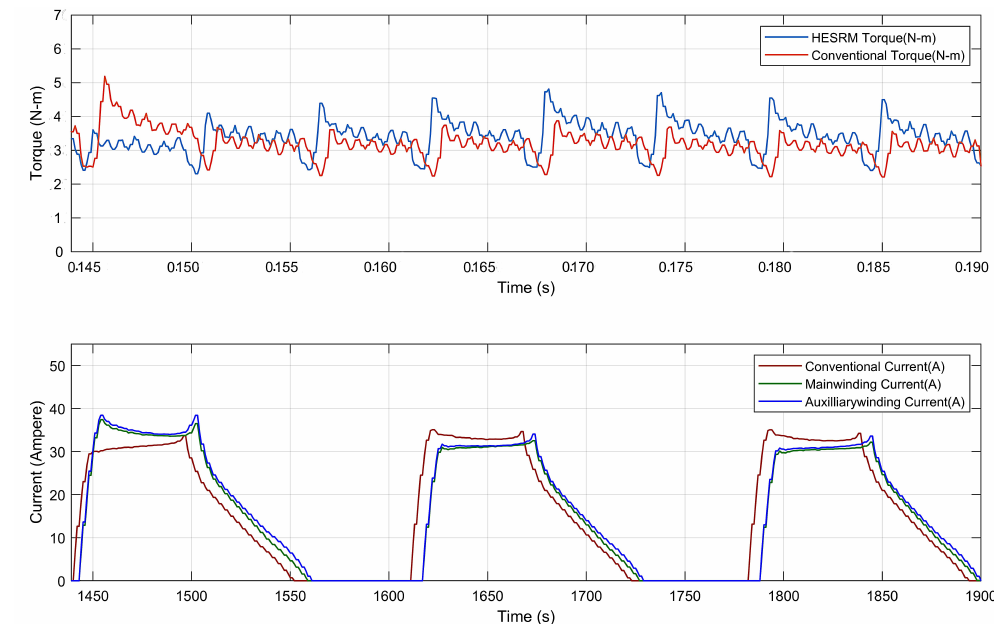
Figure 8. Comparison of characteristics of moving torque and current of two